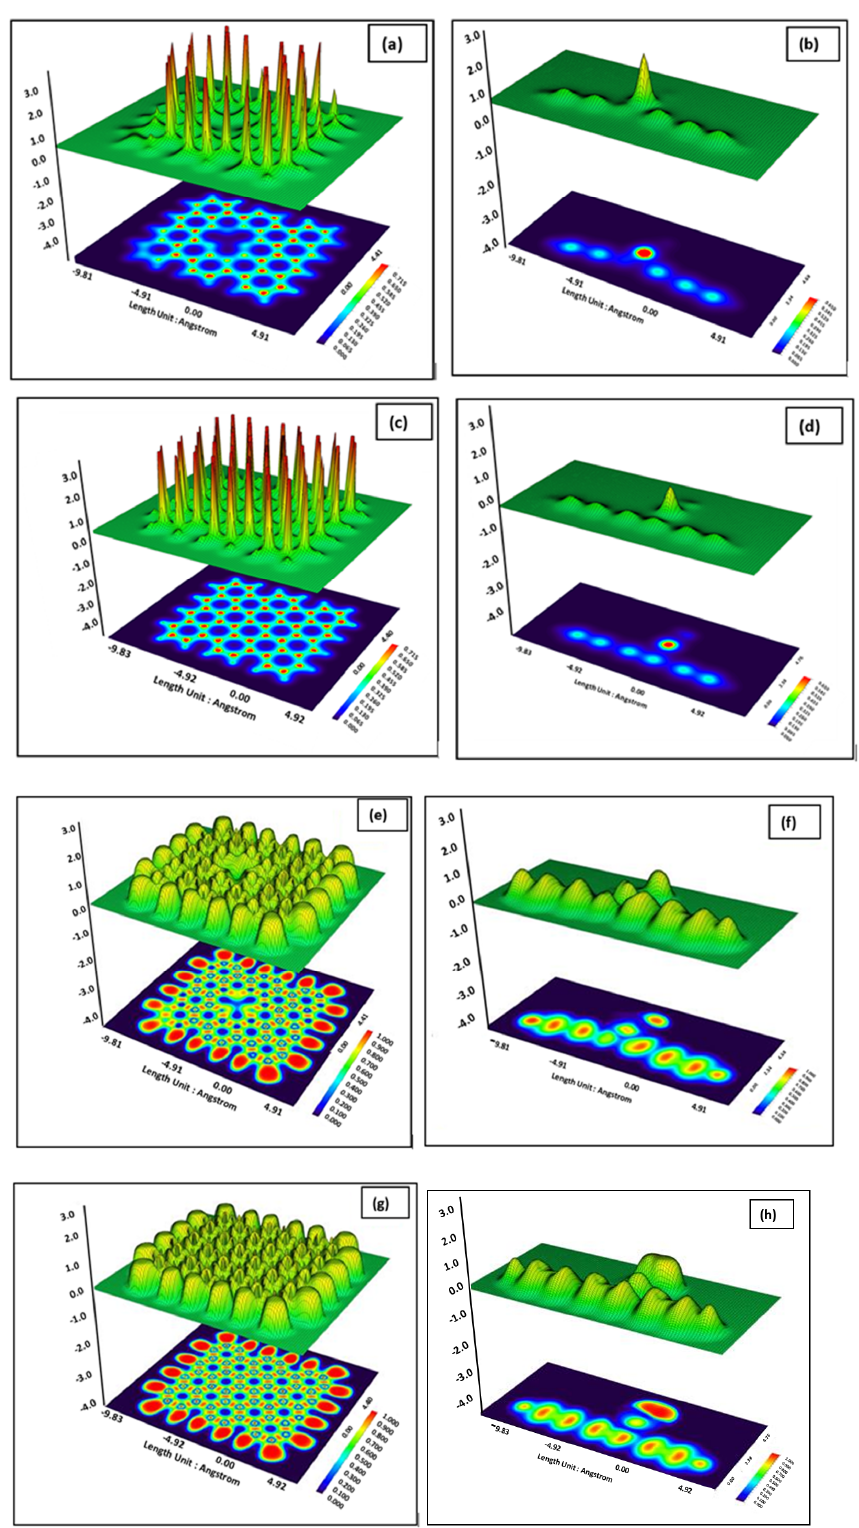
Figure 7. 2D and 3D Electron density contour plots and projections of: ( a , b ) Pd-doped graphene-H 2 , ( c , d ) Pd-decorated graphene (G)-H 2 , 2D and 3D Electron localization function plots, and projections of ( e , f ) Pd-decorated graphene (G)-H 2 and ( g , h ) Pd-decorated graphene-H 2 . The charge accumulation regions are in red, while the charge depletion regions are in blue.